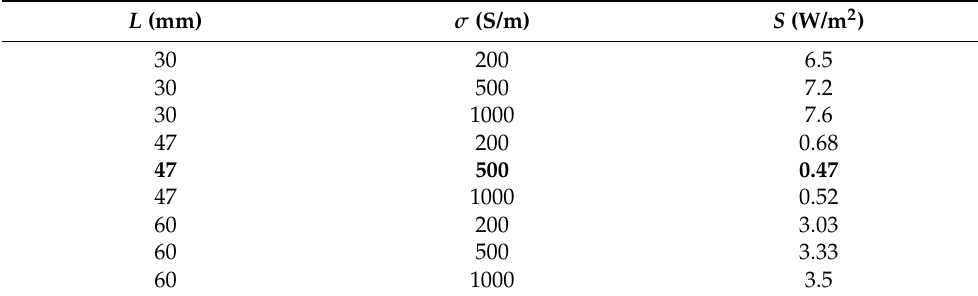
Table 1. Power density at the test point ( x = 5 mm, y = 0, z = 0) located behind the four wire array.